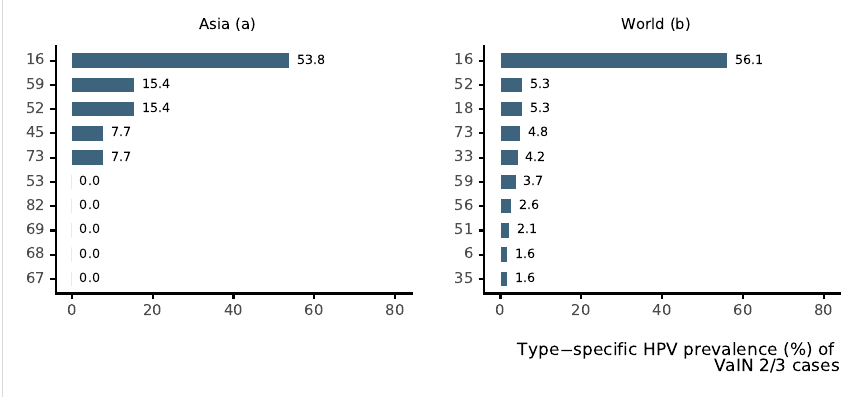
Figure 67: Comparison of the ten most frequent HPV types in VaIN 2/3 cases in Asia and the